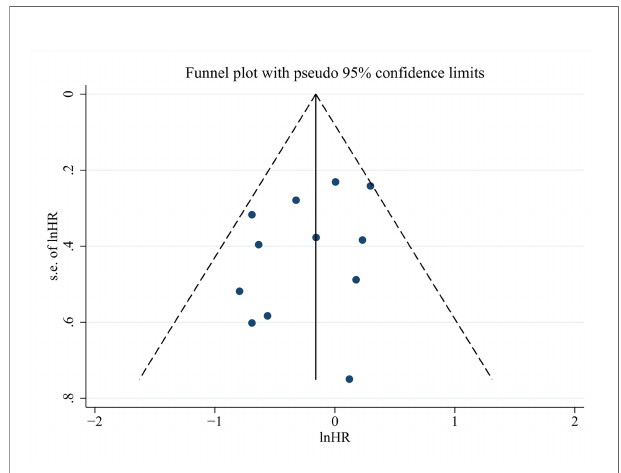
FIGURE 6 | Funnel plots for detecting publication bias of the association between neutrophil – lymphocyte ratio (NLR) and overall survival of Gallbladder carcinoma